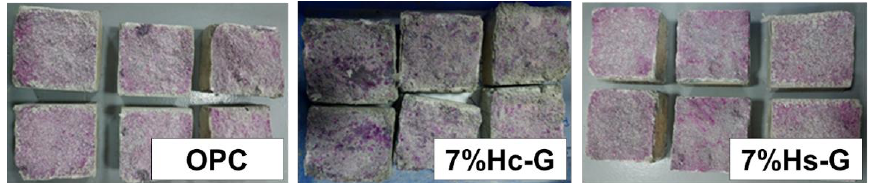
Figure 4. Carbonate morphology: ( a ) aragonite; ( b ) calcite.